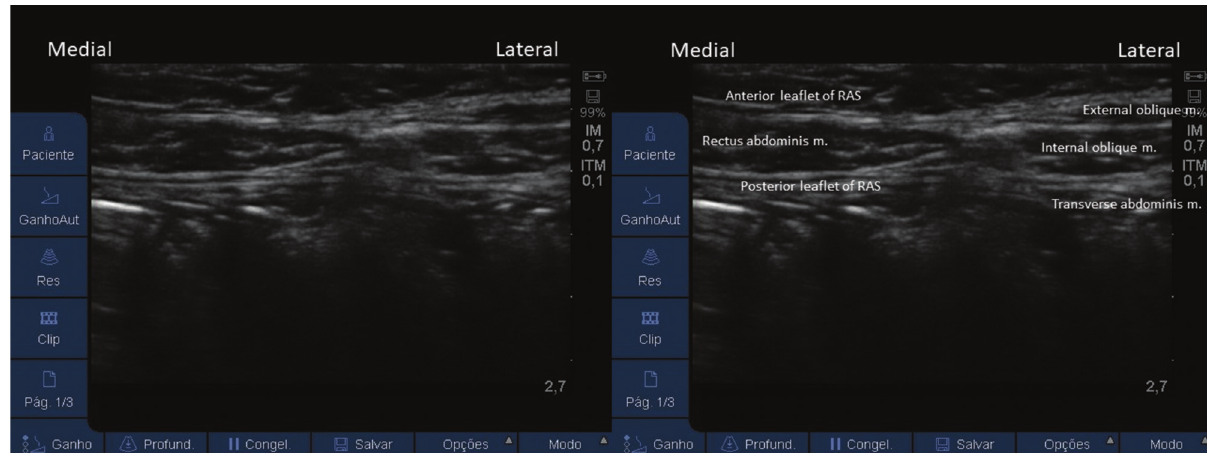
Figure 9 - Ultrasound image of the RA muscle enveloped by its sheath and the plane muscles, laterally.